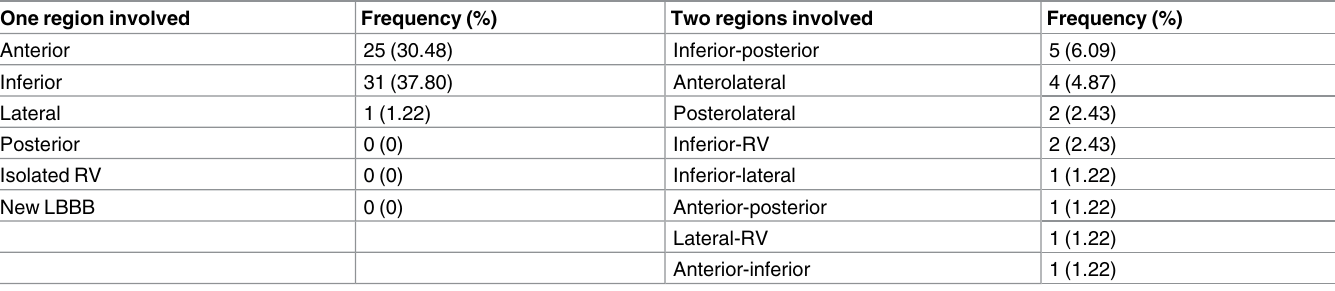
RV: right ventricle, LBBB: left bundle branch